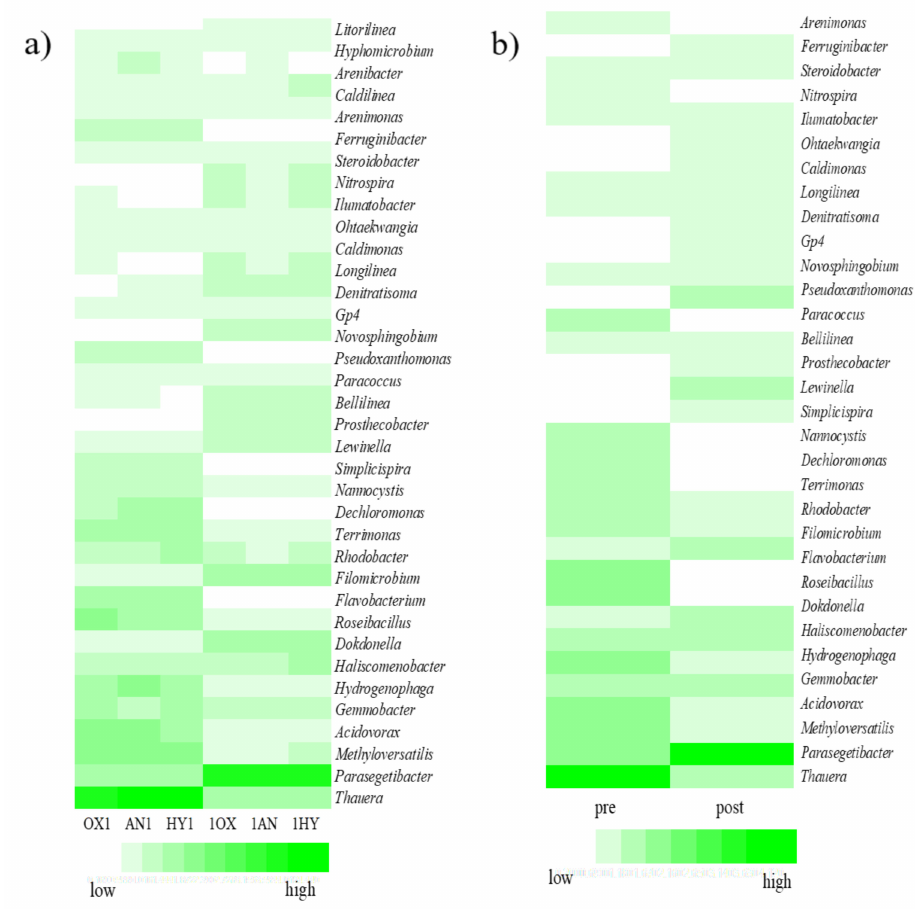
Figure 8. ( a ) The bacterial heatmap at phylum level in the anaerobic pool (OX), anoxic pool (AN) and aerobic pool (HY), containing 50% PW (pre-ozone: OX1, AN1, HYl, post-ozone: 1OX, 1AN, 1HY) and ( b ) microbial communities of high content PW in the pre-ozone treatment and post-ozone treatment